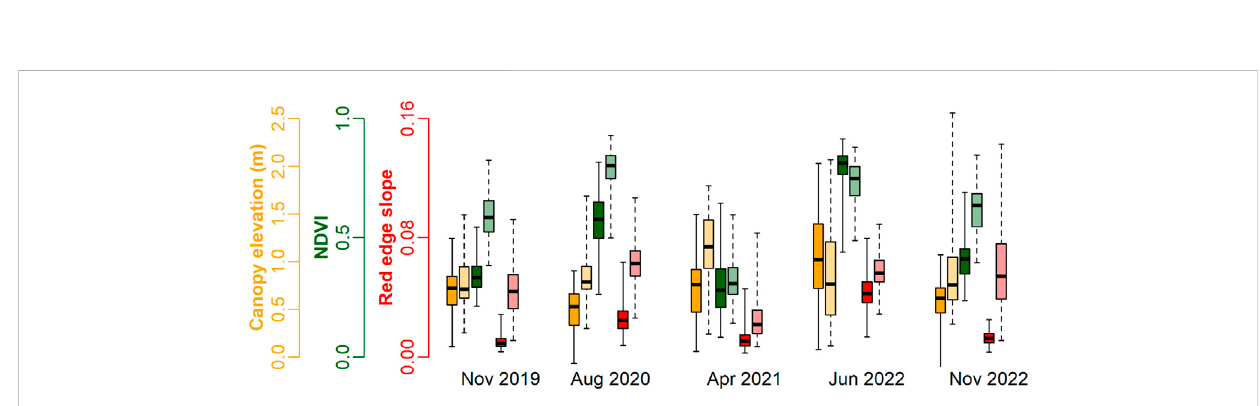
FIGURE 3 BoxplotsofDSMcanopyelevation(m)(yellow),NDVI(green),andtherededgeslope(red)of Spartinaalterni fl ora (darkhue)and Spartinapatens (light hue) for each